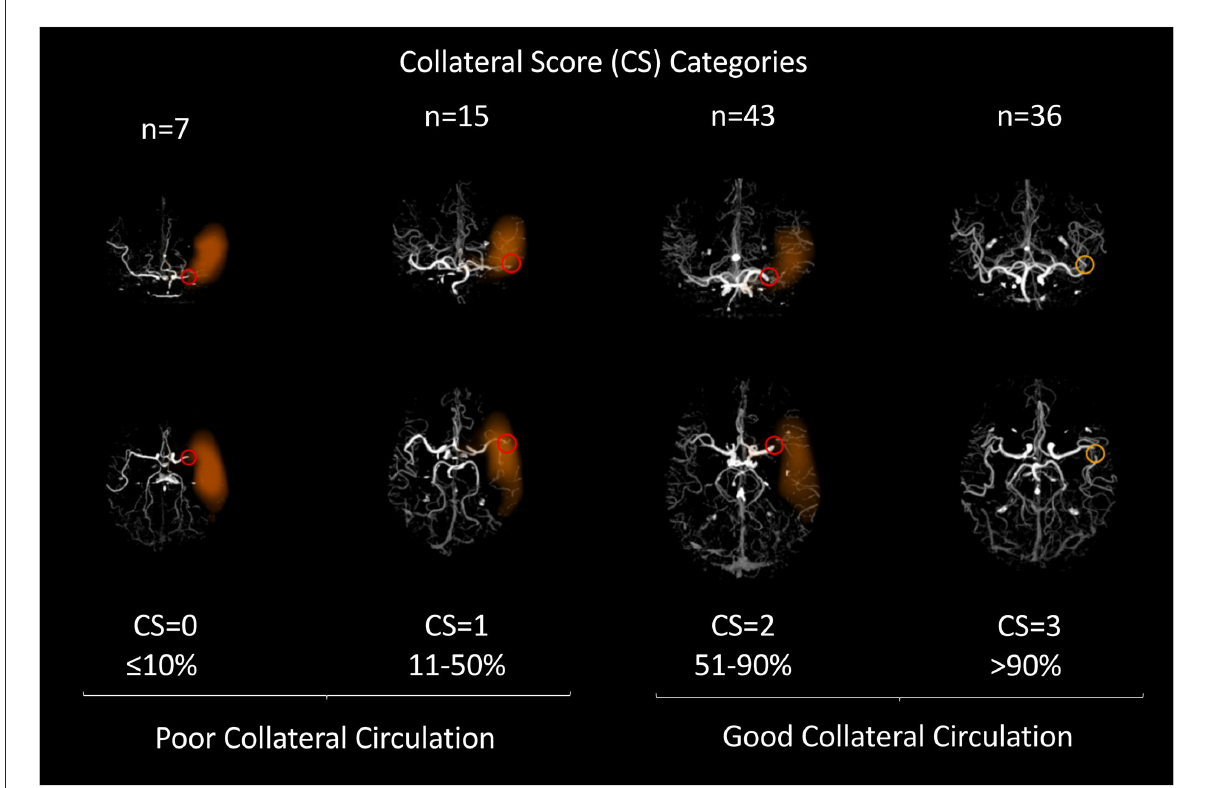
FIGURE1 Selected images of our patients processed with e-Stroke (Brainomix Ltd.) are shown as illustrative examples for each CS: 0, collateral filling of ≤ 10% of the occluded MCA territory; 1, 11–50%; 2, 51–90%; 3, > 90%. The first row shows the number of patients in each group in our study. The orange area indicates the area without collateral circulation, the red circle indicates the location of the arterial